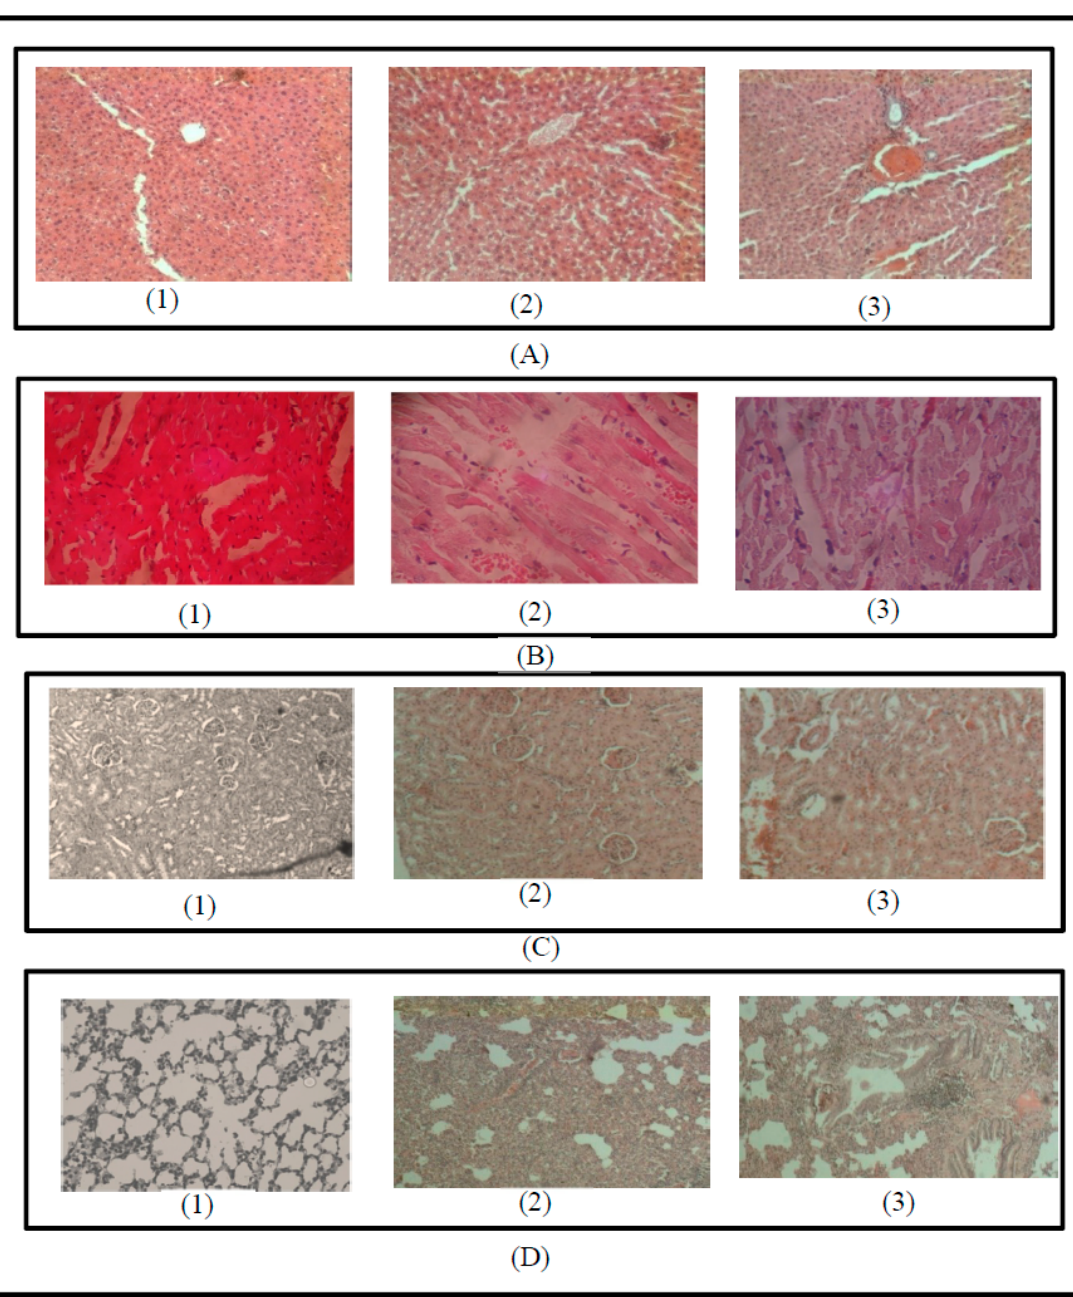
Figure 1. Representative of microscopic changes after treatment with P. fel-terrae leaf extract at doses of 500 and 1000 mg/kg BW (10 × 10), scale bars: 10 × 40. ( A ) Liver; ( B ) heart; ( C ) kidney; ( D ) lung; (1) normal group; (2) group of extract at doses of 500 mg/kg BW; (3) group of extract at doses of 1000 mg/kg BW.